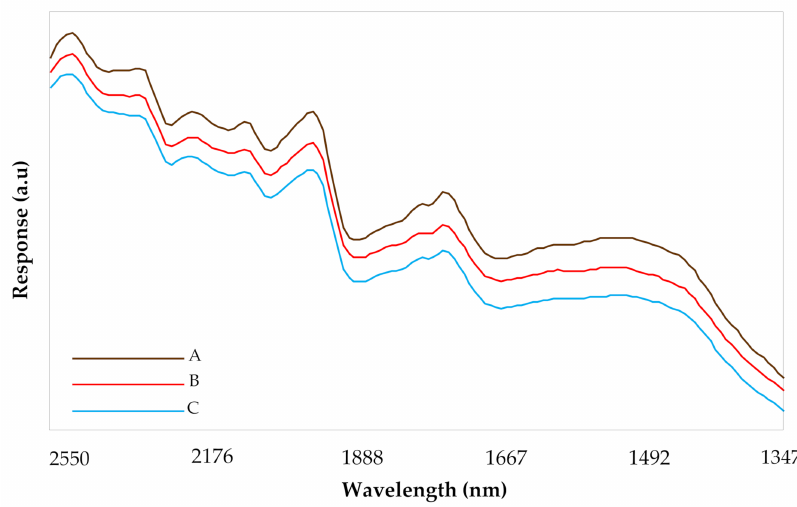
Figure A2. The reproducibility of the spectral measurements for a random sample that is tested with 3-h intervals. Spectra were collected at given times; A: 11 p.m. B: 2 p.m. C: 5